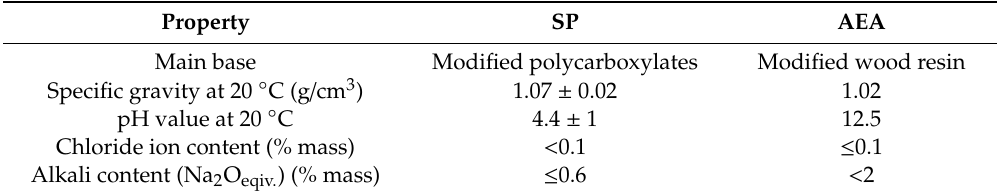
Table 2. The properties of the admixtures.